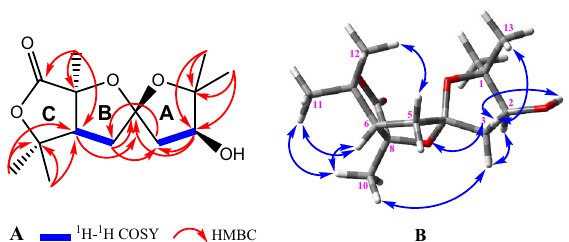
Figure 8. ( A ) 1 H– 1 H COSY and key HMBC and ( B ) NOESY correlations of 3 .